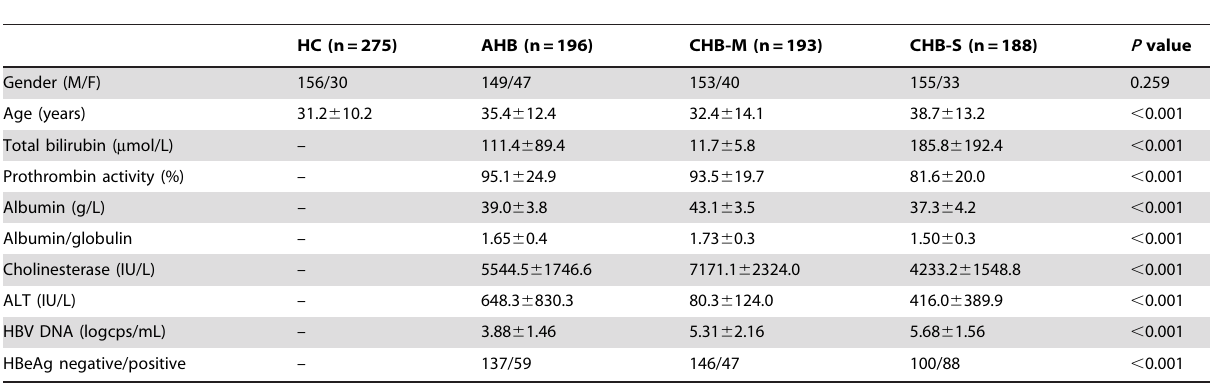
Table 1. Clinical details of the studied